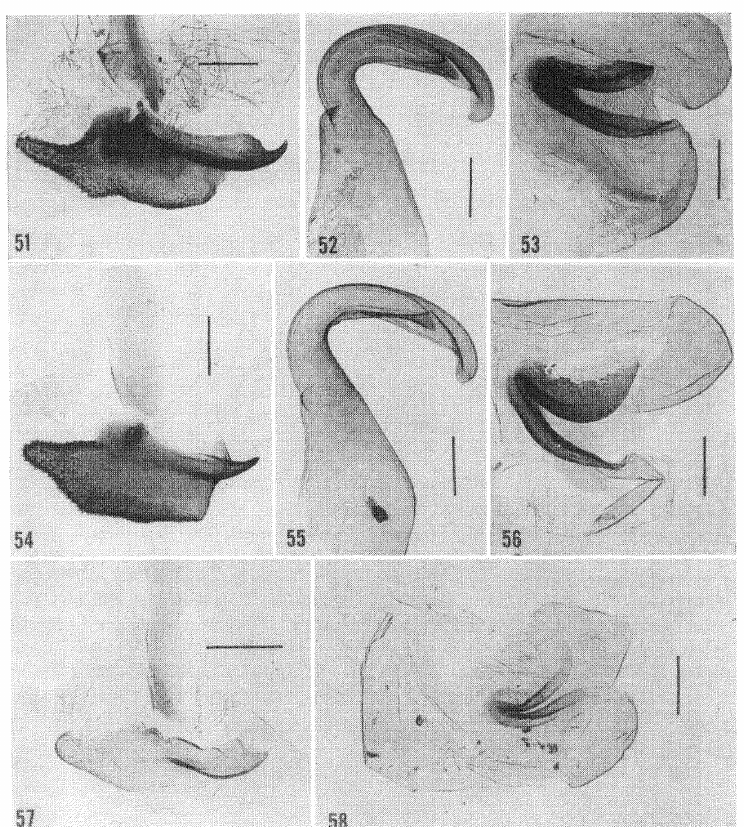
Figures 51-58. Male genital phallomeres ot Hostilia spp. 51-53. (1405 L). H. protera (from $ shown in Fig. 4.4). 54-56. (170 ANSP). H. protera (from $ shown in Fi,g. 43). 57-58. (1406 L). H. claitlera (from shown in Fig. 42). (scale 0.2